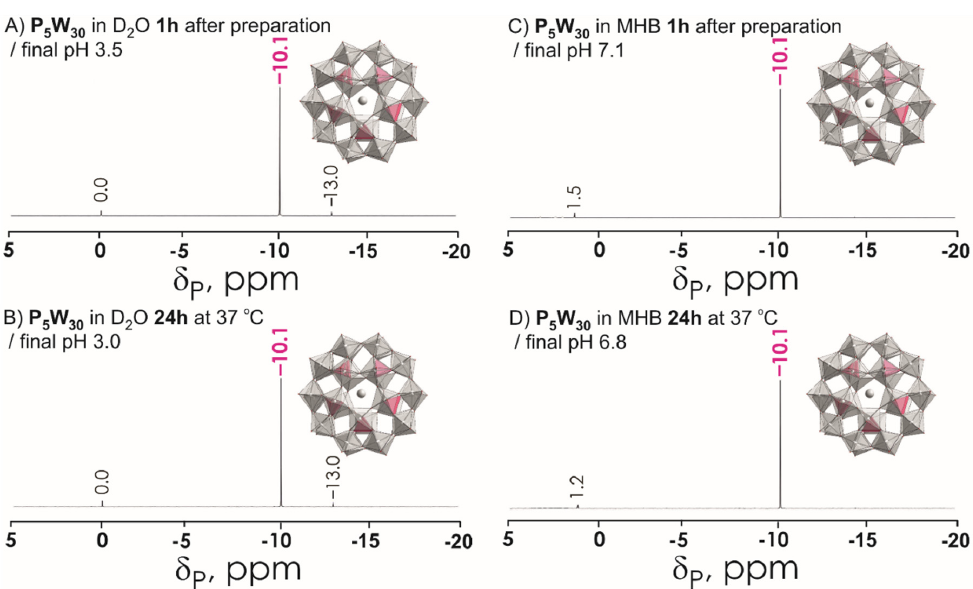
Figure 3. 31 P NMR spectra of P 5 W 30 10 mM solutions ( A ) in D 2 O recorded approximately 1 h after preparation; ( B ) in D 2 O recorded after incubation for 24 h at 37 °C; ( C ) in Mueller–Hinton broth (MHB) recorded approximately 1 h after preparation; ( D ) in Mueller–Hinton broth (MHB) recorded after incubation for 24 h at 37 °C. Signals at 0 ppm, 1.2, and 1.5 correspond to free phosphate H x PO 4(3 − x ) − ( x = 0–3). The signal at − 10.1 ppm corresponds to 5 equivalent P ions in P 5 W 30 shown in magenta in polyhedral presentation. Color code: {WO 6 }, light grey; {PO 4 }, magenta; O, red; Na, grey.